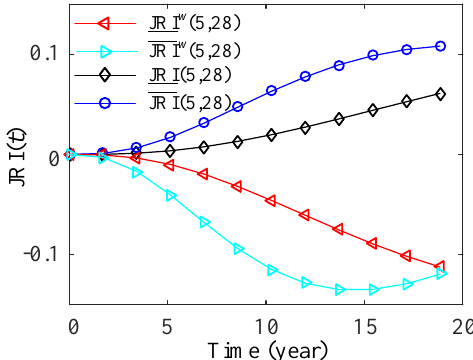
Figure 19. Lower and upper JRI of components 5 and 28.